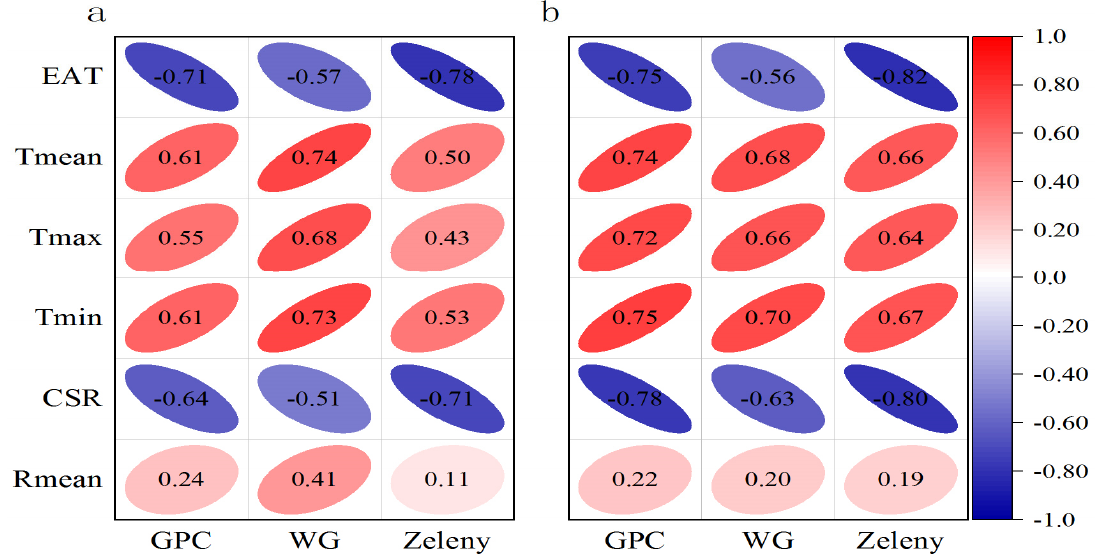
Figure 2. The correlation between temperature and radiation and protein content, gluten content,